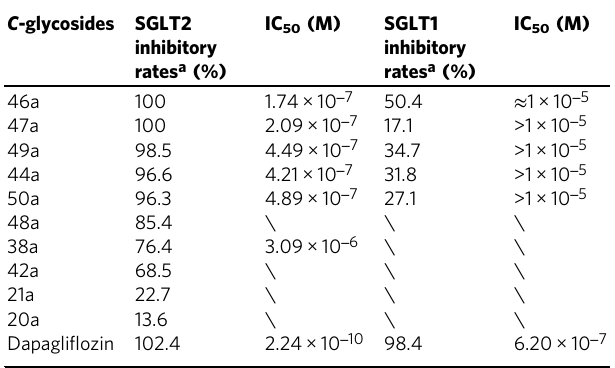
Table 1 Inhibition and selectivity of representative C - glycosides on SGLT2.